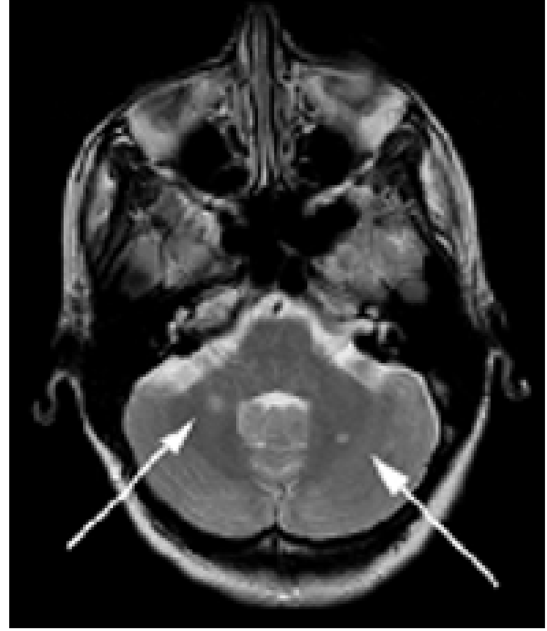
Fig. 2 Brain MRI showing two MS lesions (white arrows) in the cerebellar white